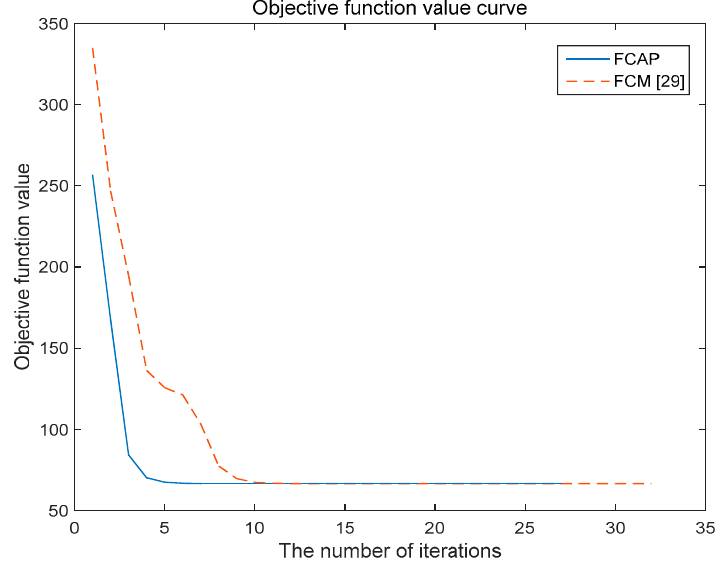
Figure 5. Objective function value curve for the Iris data set.